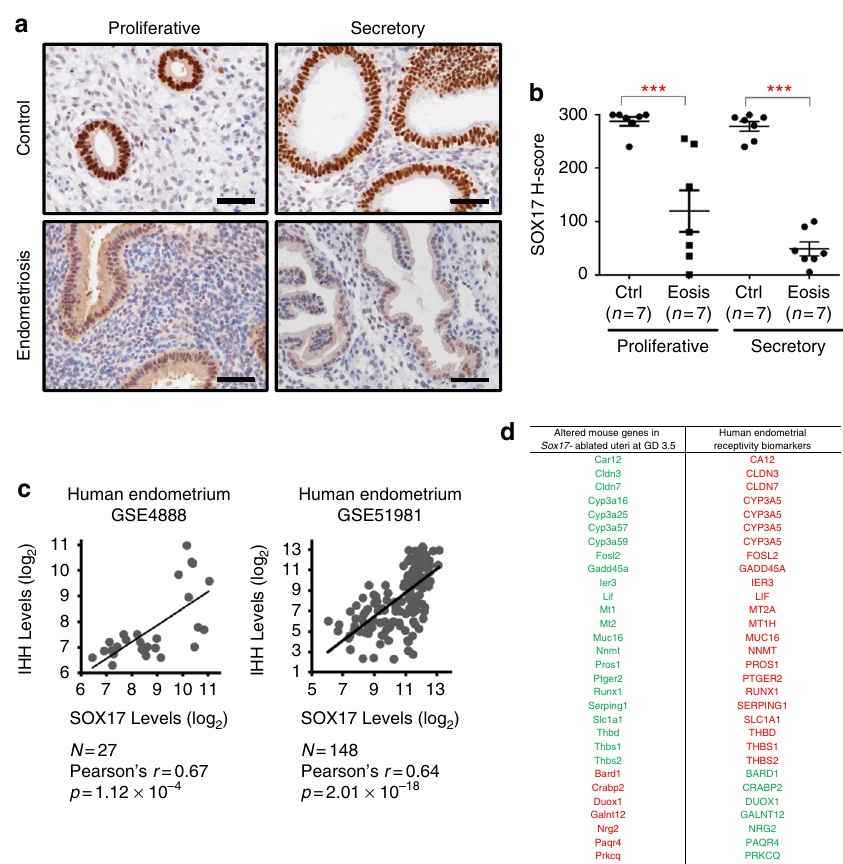
Fig. 5 A conserved SOX17 pathway for endometrial receptivity in humans. Immunohistochemical staining a and H-score quanti fi cation b of SOX17 in human endometrial section from women with and without endometriosis at proliferative and secretory phase of the menstrual cycle. Scale bars: 50 µ m. * P < 0.001 (ANOVA with Tukey ’ s post hoc test). Data are presented as means ± S.E.M. c Correlation of levels between IHH and SOX17 in human endometrium (GSE4888 and GSE51981). d Comparison of genes altered in the Sox17 -ablated uteri at GD 3.5 with human endometrial receptivity biomarkers. Green font denotes gene downregulation; red font denotes gene